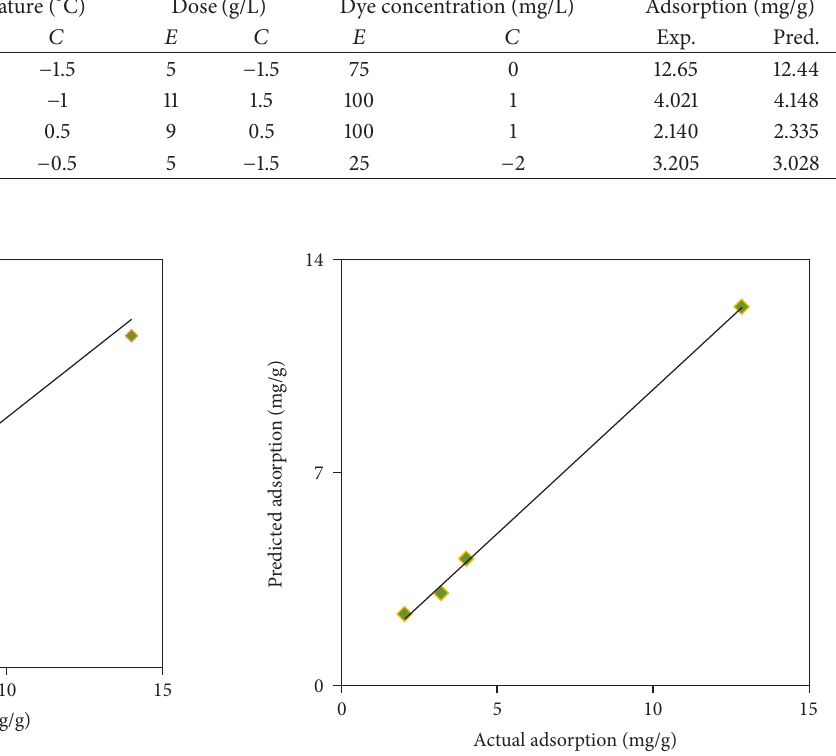
Figure 4: Actual (mg/g) and predicted plot of the adsorption of the AB1 for the model development sets.